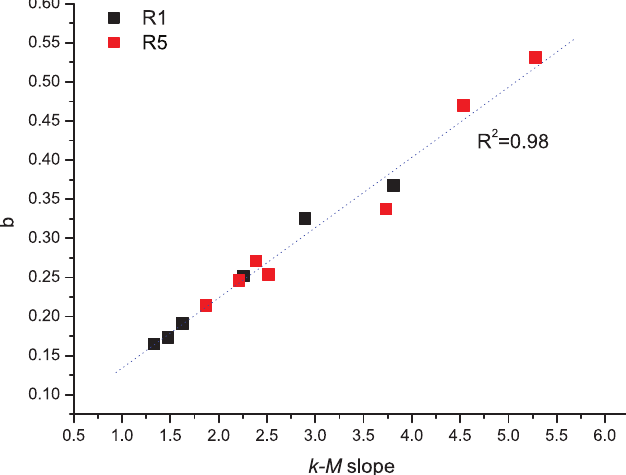
Figure 8. Relationship between the k-M slope and the b -value for the synthetic seismicity during the first (black squares) and the fifth run (red squares). The linear correlation is very good ( R 2 , 0.98).